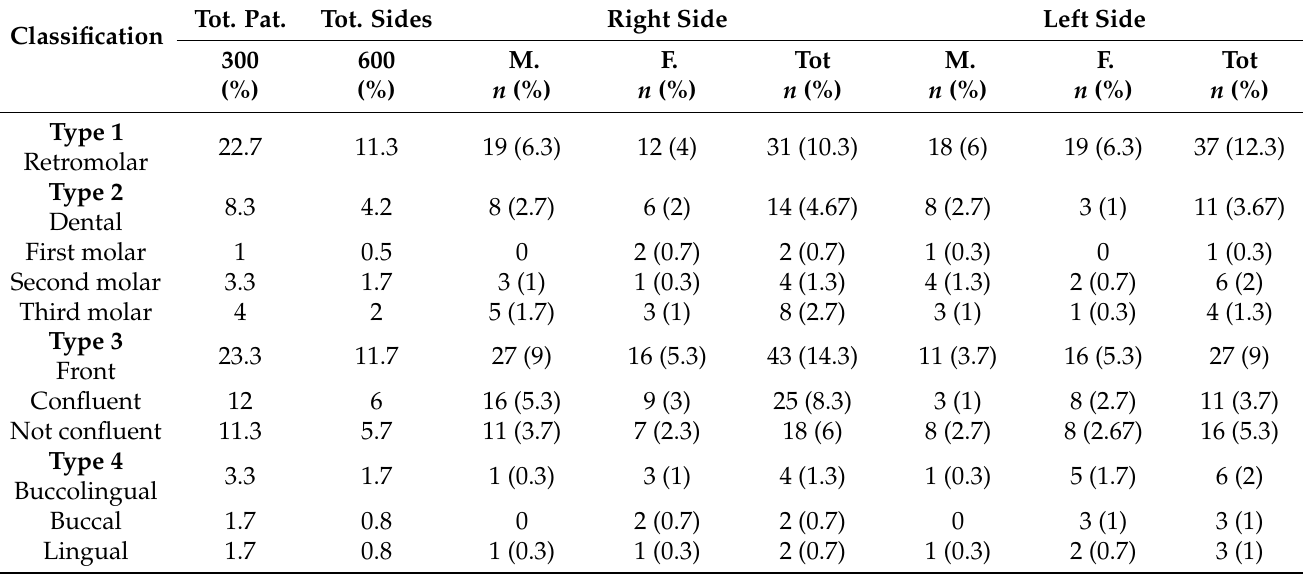
Table 2. Prevalence of bifid mandibular canals based on gender, type, and location.